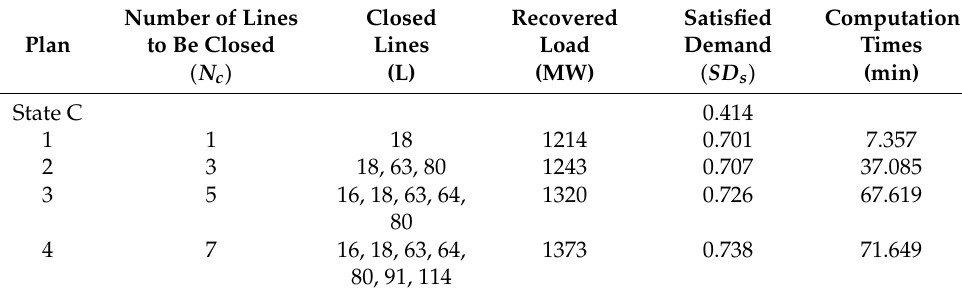
Table 1. Optimal recovery plans obtained using Algorithm 2 in stage s =